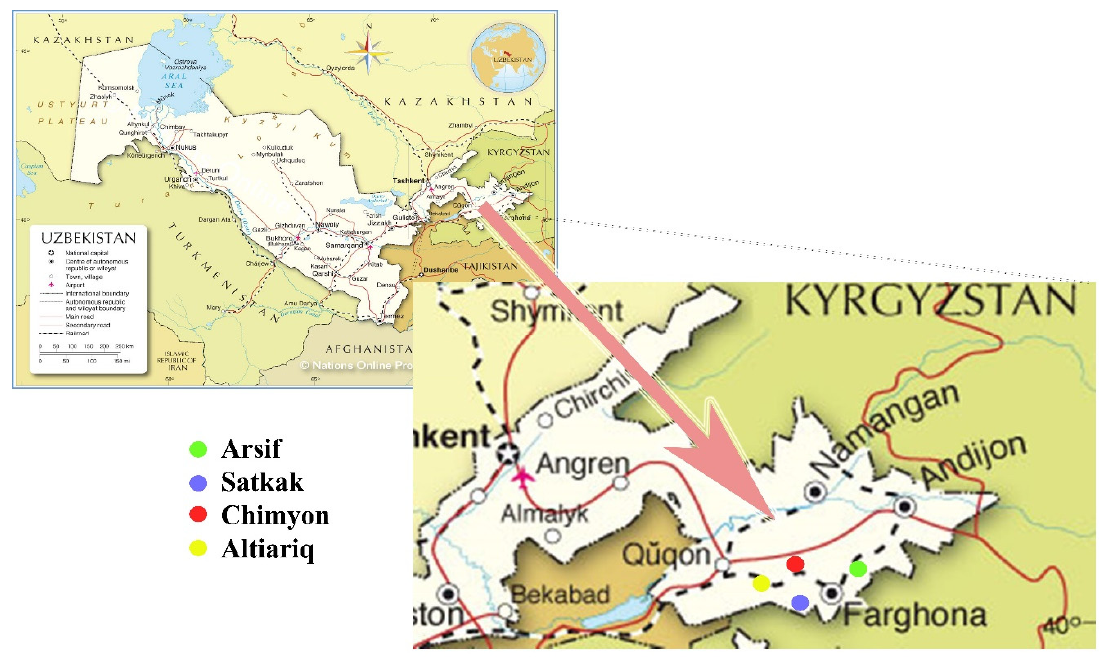
Figure 1. Map of research area, Fergana valley (Source: https://www.nationsonline.org/oneworld/map/uzbekistan-political-map.htm (accessed on 5 May 2022).